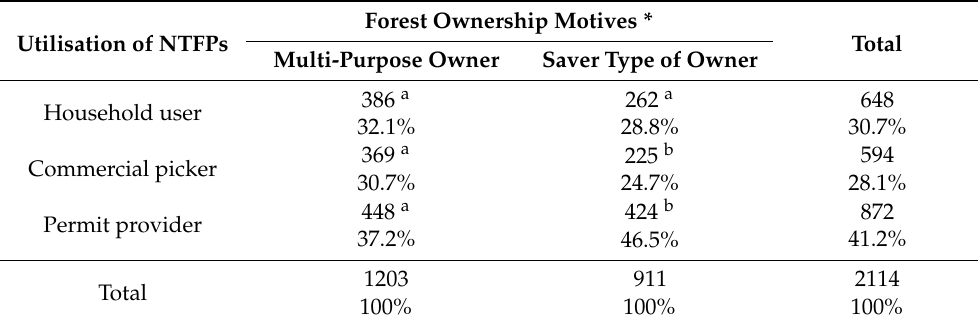
Table 8. Counts and proportions of cross-tabulated clusterings of forest ownership motives and utilisation of NTFPs. The total number of observations with valid group membership information for both groupings is 2114. Pearson Chi square, χ 2 (2) = 19.33, p < 0.001, Cramer’s V = 0.096.